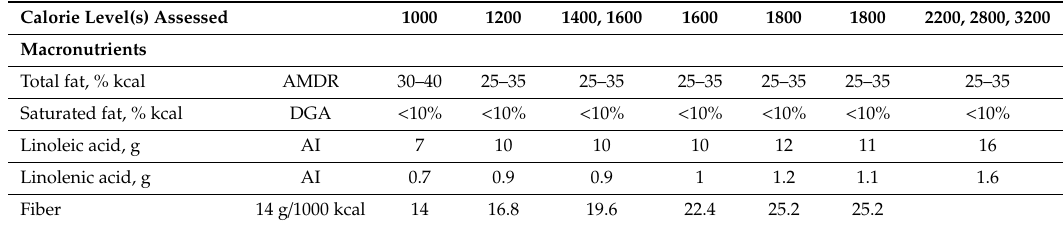
Table 2. Institute of Medicine guidance on fat and fiber intake